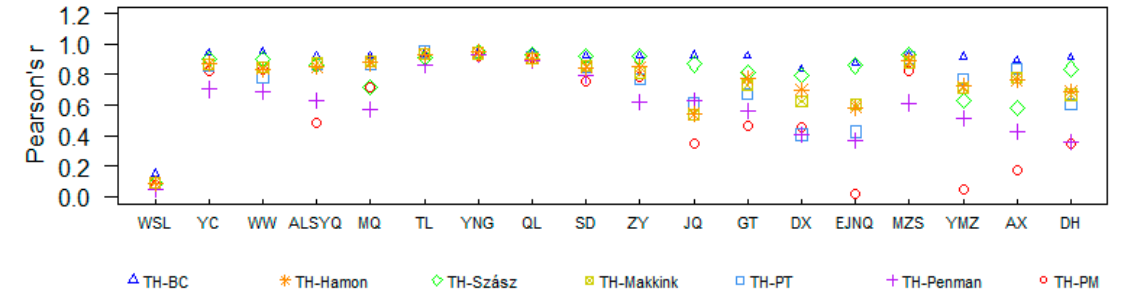
Figure 8. Correlation coefficients of the eight SPEI series at all stations.